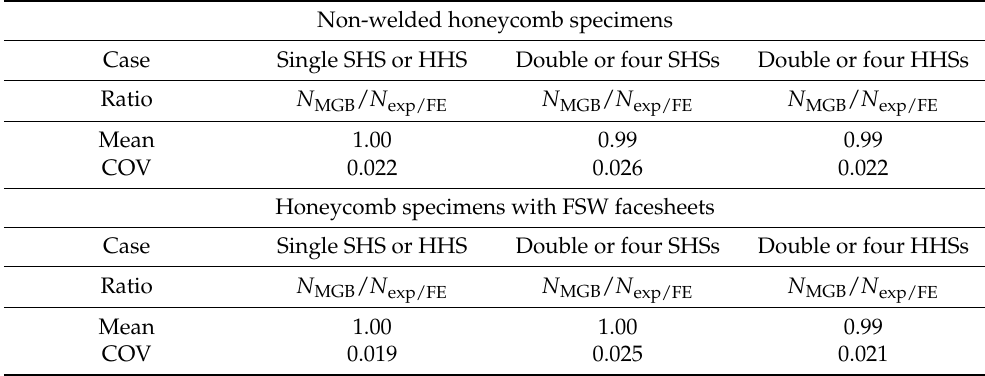
Figure 15. Comparisons of test and FE results with modified GB 50429: ( a ) Non-welded honeycomb specimens; ( b ) Honeycomb specimens with FSW facesheets. Table 7. Comparison of test/FE results with modified predicted